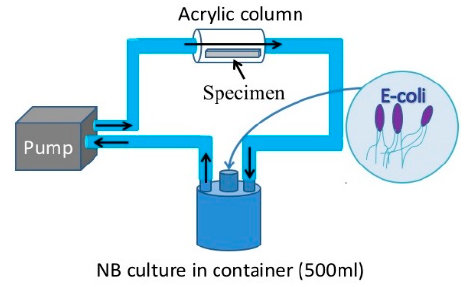
Figure 2. The current LBR for this investigation.